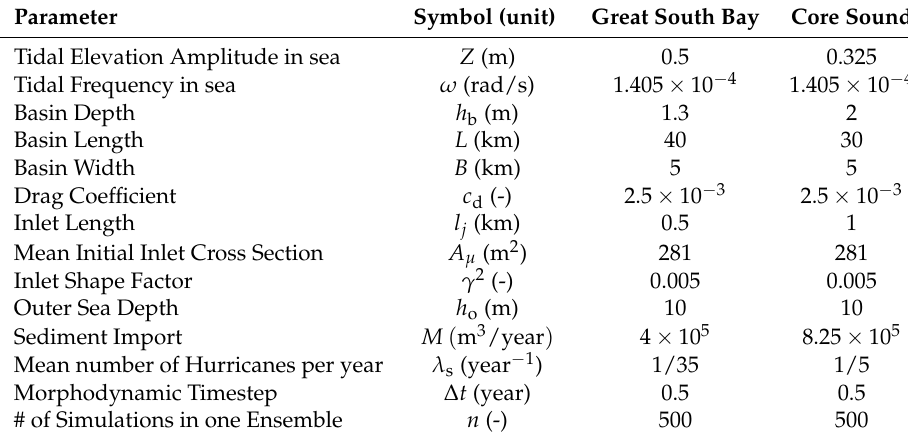
Table 1. Model parameters used in this